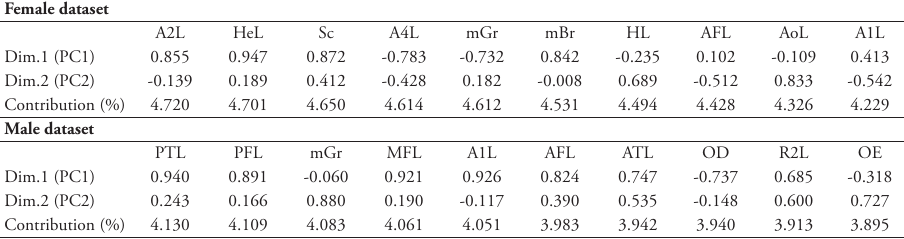
Table 3. Correlation and contribution in the percentage for the first and second dimensions (PC1 and PC2) of Principle Component Analysis (PCA) of the 10 most contributing morphometric characters based on female and male datasets (upper and lower tables,